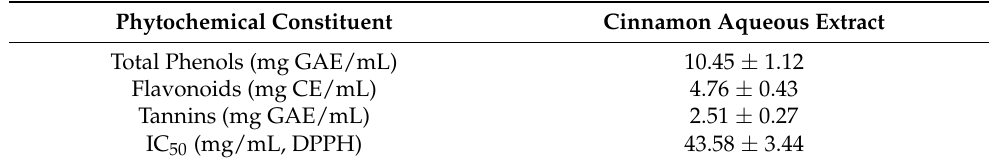
Table 1. Total phenolic, flavonoid, and tannins contents, and antioxidant activity of the cinnamon aqueous